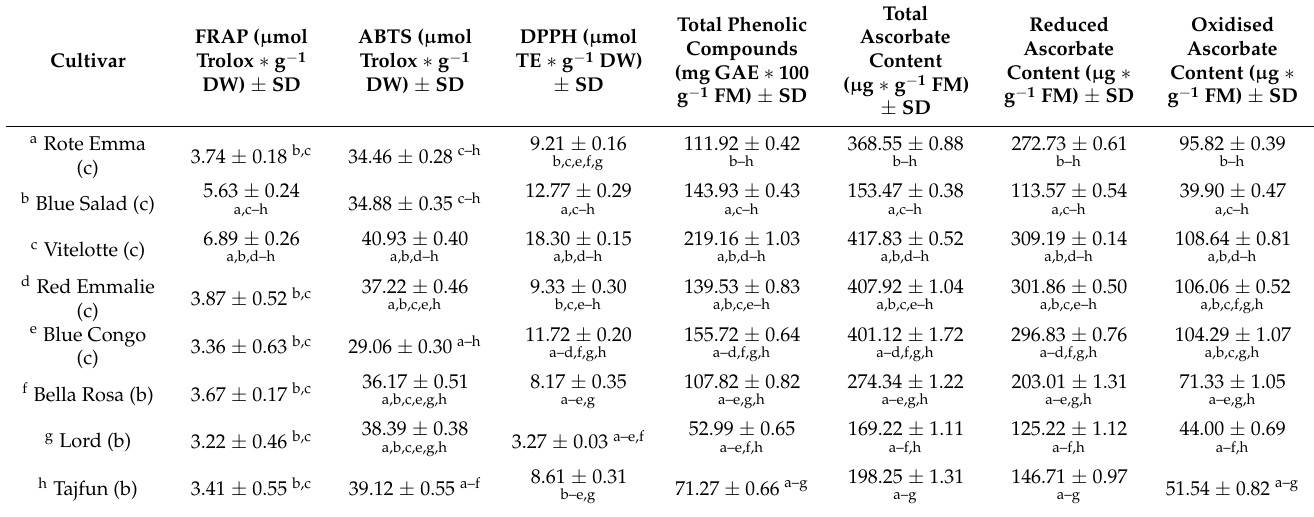
Table 5. Total, reduced, and oxidised ascorbate contents and antioxidant properties as determined in FRAP, ABTS, and DPPH